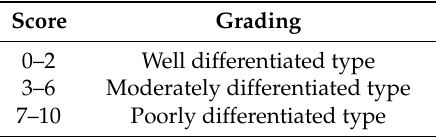
Table 2. GAPP: Total Score and Grading.